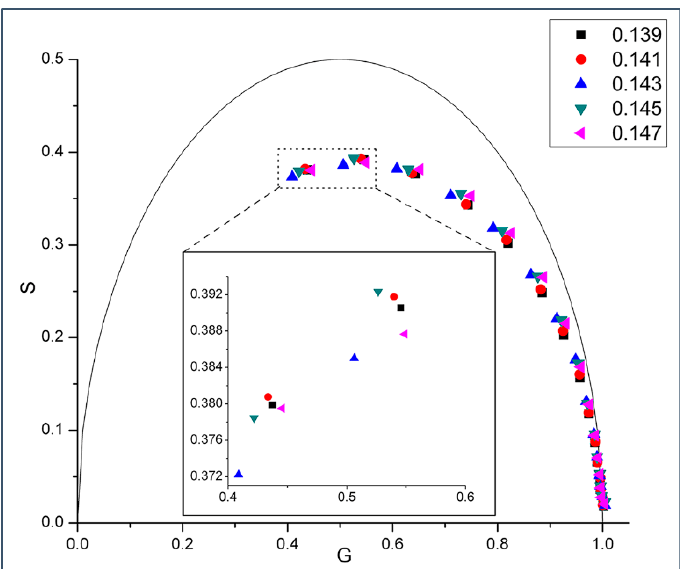
Figure 1. Phasor plot of intrinsic gramicidin fluorescence in various gramicidin D (gD)/DMPC multilamellar vesicles (MLVs) measured at 37 °C using 15 different modulation frequencies: (from left to right) 200.00, 143.94, 103.59, 74.55, 53.65, 38.61, 27.79, 20.00, 14.39, 10.36, 7.46, 5.37, 3.86, 2.78, and 2.00 MHz. The semi-circular arc is called the “universal circle” [21]. Inlet: enlarged phasor data measured at 200.00 and 143.94 MHz; the relative errors of G (=M cos φ ) and S (=M sin φ ) are: ∆ G = 0.00098–0.00101 (200 MHz) and 0.00139–0.00141 (143.9 MHz), and ∆ S = 0.00096–0.00099 (200 MHz) and 0.00096–0.00099 (143.9 MHz).